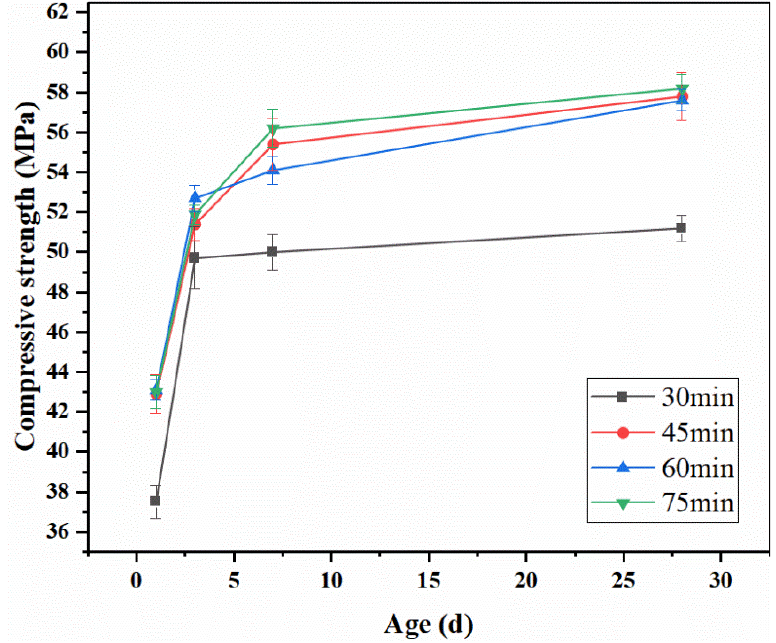
Figure 13. Compressive strength of cement with different calcination